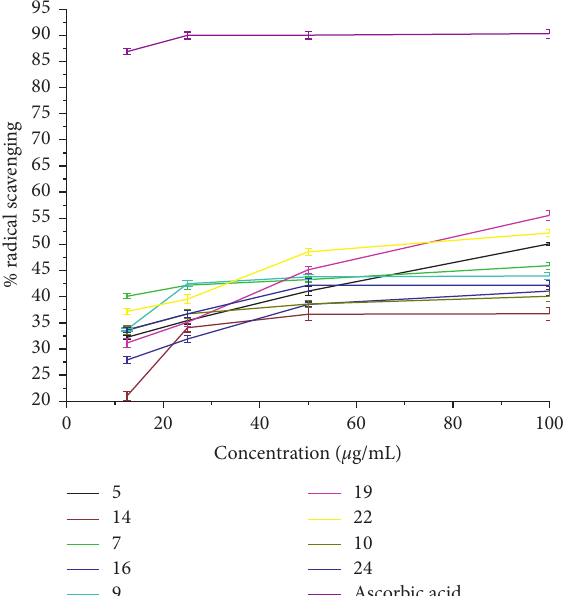
Figure 3: Antibacterial activity of synthetic compounds at 500 μ g/mL.